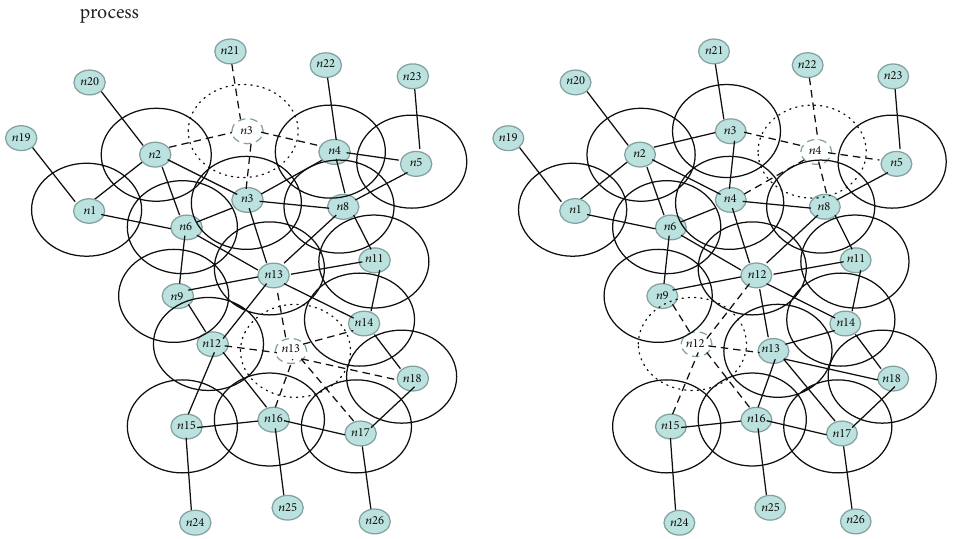
(f) Recovery process of node n 4 and node n 12 Figure 3: